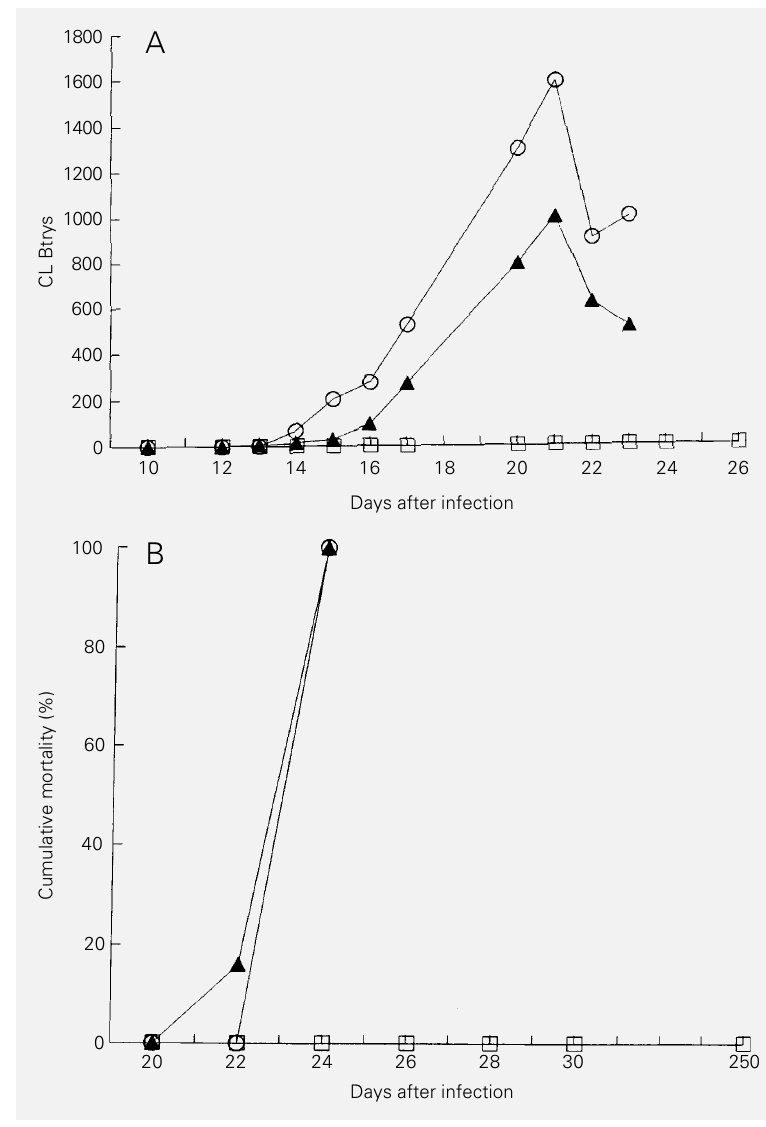
Figure 2 - Parasitemia (A) and mortality (B) of mice pretreated iv with anti-CL (open squares) or anti-Y (filled triangles) serum before infection with bloodstream trypomastigotes (Btrys) of the CL strain of Trypanosoma cruzi . Control animals were injected iv with normal mouse serum (open circles). Each point represents the mean of 6